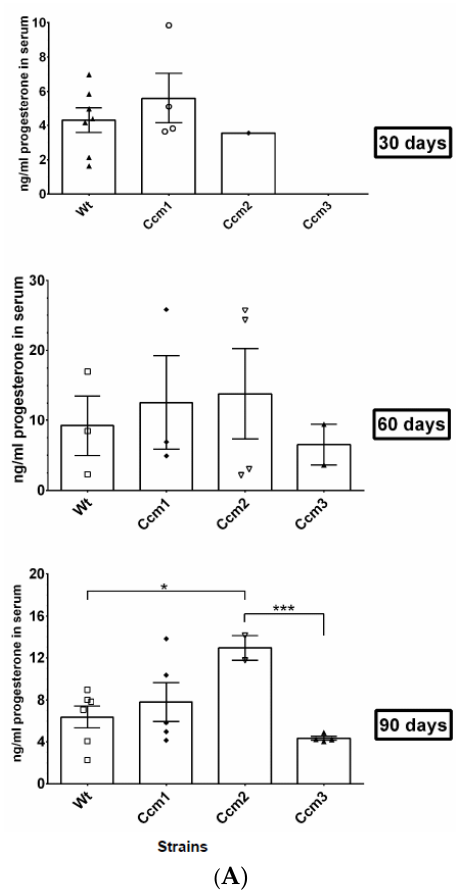
( D ) Figure 6. Perturbation of homeostasis of PRG is associated with BBB disruption. ( A ) No obvious differences in PRG levels in mice serum were observed in the 30 ‐ day treatment groups (upper panel). Interestingly, free ‐ circulating PRG levels in the mice serum have an overall two ‐ fold increase among all treated genotypes in the 60 ‐ day treatment groups (although not statistically significant, middle panel). In the 90 ‐ day treatment groups, free ‐ circulating PRG levels regressed to normal